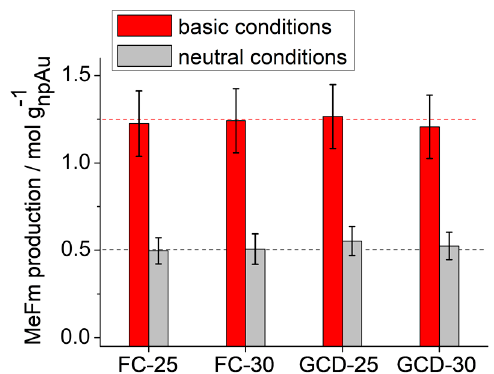
Figure 3. Production after 24 h over npAu samples containing less than 1 at % Ag prepared by FC using Au 25 Ag 75 (FC-25) and Au 30 Ag 70 (FC-30) as starting alloys as well as by GCD using Au 25 Ag 75 (GCD-25) and from Au 30 Ag 70 (GCD-30). The bar graphs show the comparison of the yield obtained under neutral and basic conditions. Catalytic experiments were performed at 60 °C and 3 bar O 2 for 24 h.